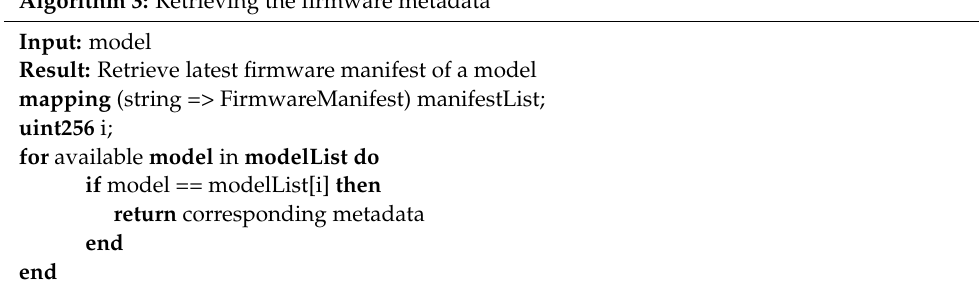
Algorithm 3: Retrieving the firmware